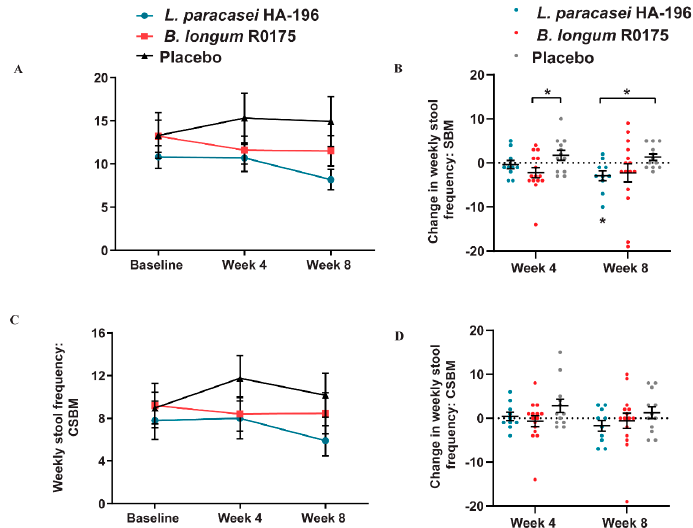
Figure 6. Effect of Lactobacillus paracasei HA-196 and Bifidobacterium longum R0175 on frequency of bowel movements in participants with IBS-D. ( A ) Weekly SBM at baseline, week 4 and week 8, ( B ) Change in total SBM from baseline to week 4 and week 8, ( C ) Total CSBM at baseline, week 4 and week 8, and ( D ) Change in weekly CSBM from baseline to week 4 and week 8. L. paracasei group n = 10, B. longum group n = 15, placebo group n = 12; data represented as mean ± SD; * p < 0.05, ** p < 0.01; SBM; spontaneous bowel movement; CSBM, complete spontaneous bowel movement; L. paracasei , Lactobacillus paracasei HA-196; B. longum, Bifidobacterium longum R0175. Furthermore, IBS-D participants in the L. paracasei and placebo groups reported significant decreases in stool consistency at 4 weeks; however, the L. paracasei group was the only group to report a significant 15% within group decrease in stool consistency after 8 weeks (Table 4). There were no significant between-group differences for CSBM or stool consistency among the three groups at the end of 4 or 8 weeks of the supplementation period.